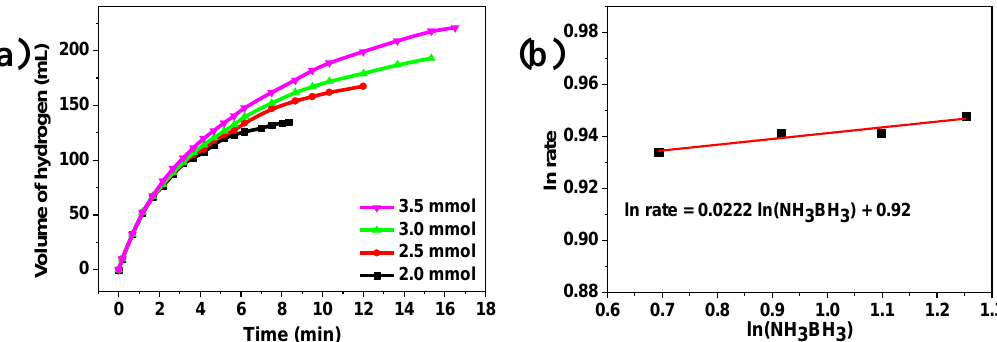
Figure 9. ( a ) Volume of hydrogen vs. reaction time at di ff erent Cu 0.4 Co 0.6 MoO 4 / g-C 3 N 4 dosages;